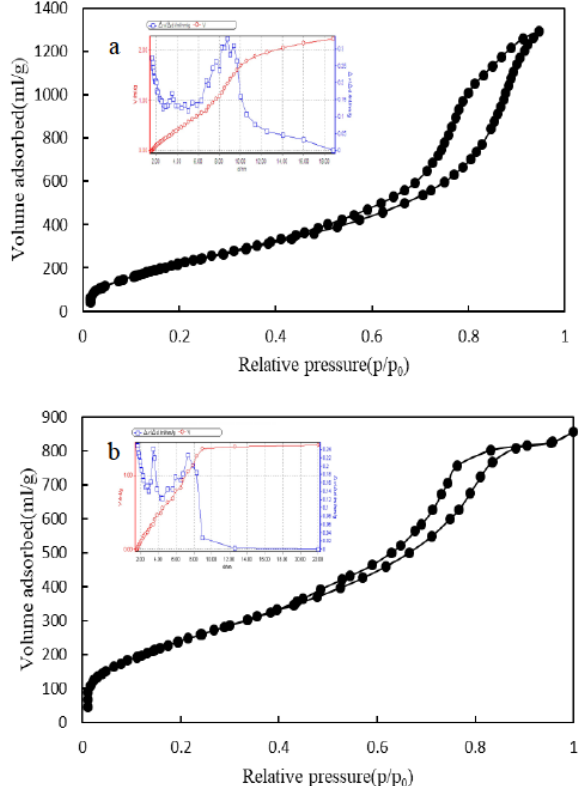
Figure 2: N 2 adsorption-desorption isotherm of SiO 2 (AG) (a: hy- drophobic; b:hydrophilic) (insets are BJH differential integral hole volume and pore size distribution curve of SiO 2